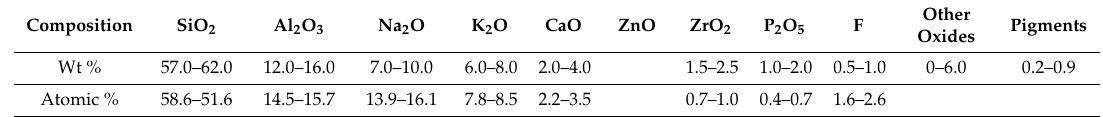
Table 1. The compositions of the fluorapatite disks used in this study